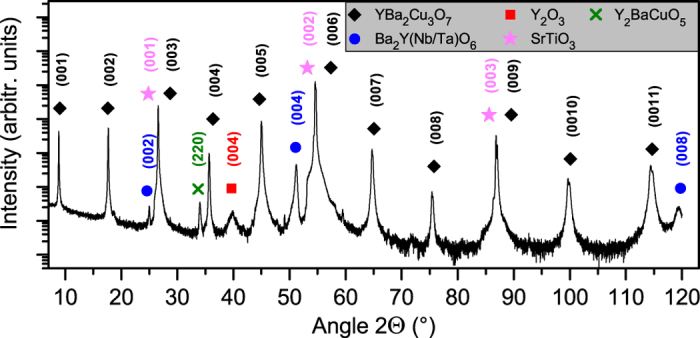
Θ-2Θ scan of the BYNTO:YBCO sample grown with fDep = 1 Hz.Co Kα was used for the measurement.